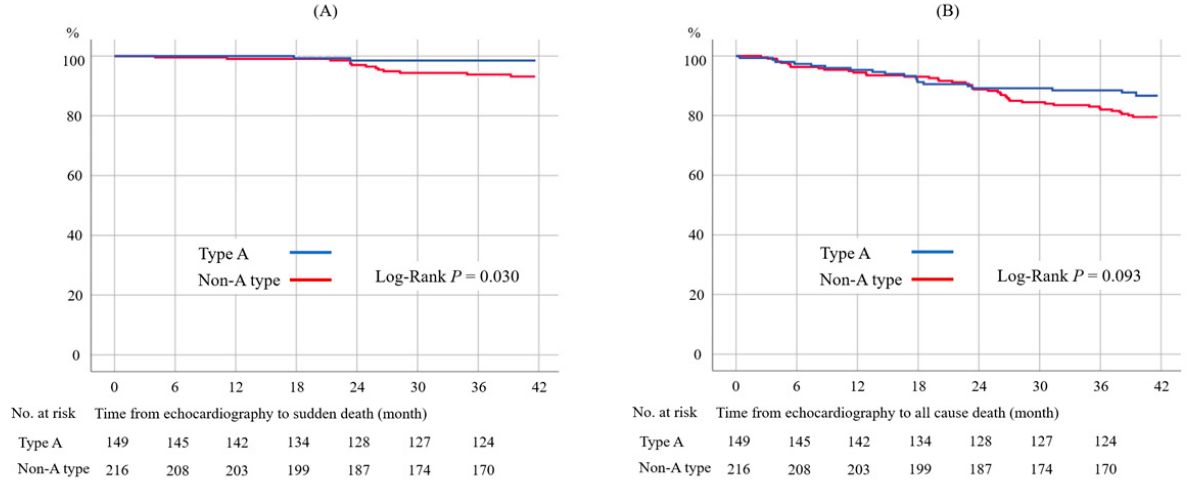
type blood (Figure 2A, log-rank p = 0.030). The frequency of all-cause death was higher, (Figure 2B, log-rank p = 0.093).